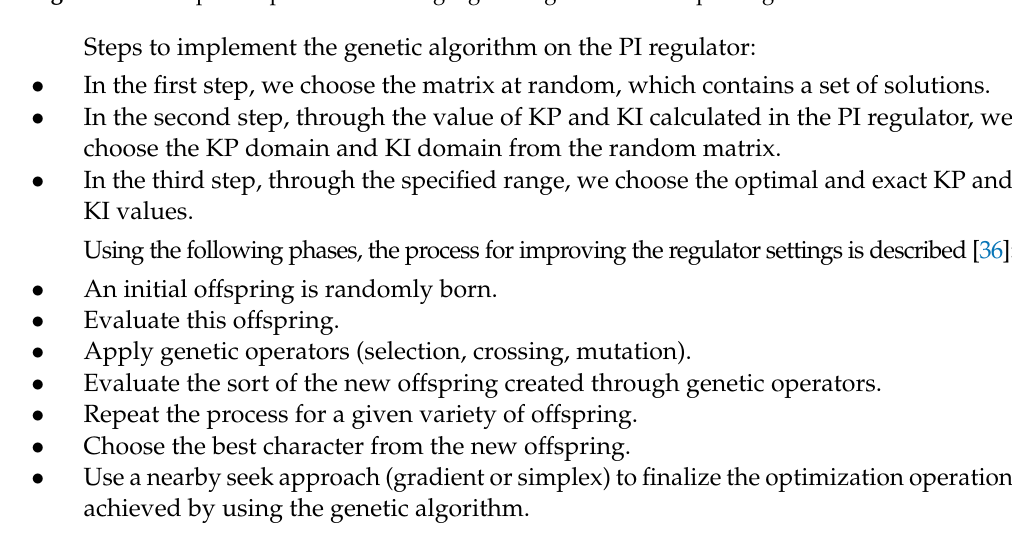
Figure 11. Principle of optimization using a genetic gradient or simplex algorithm.